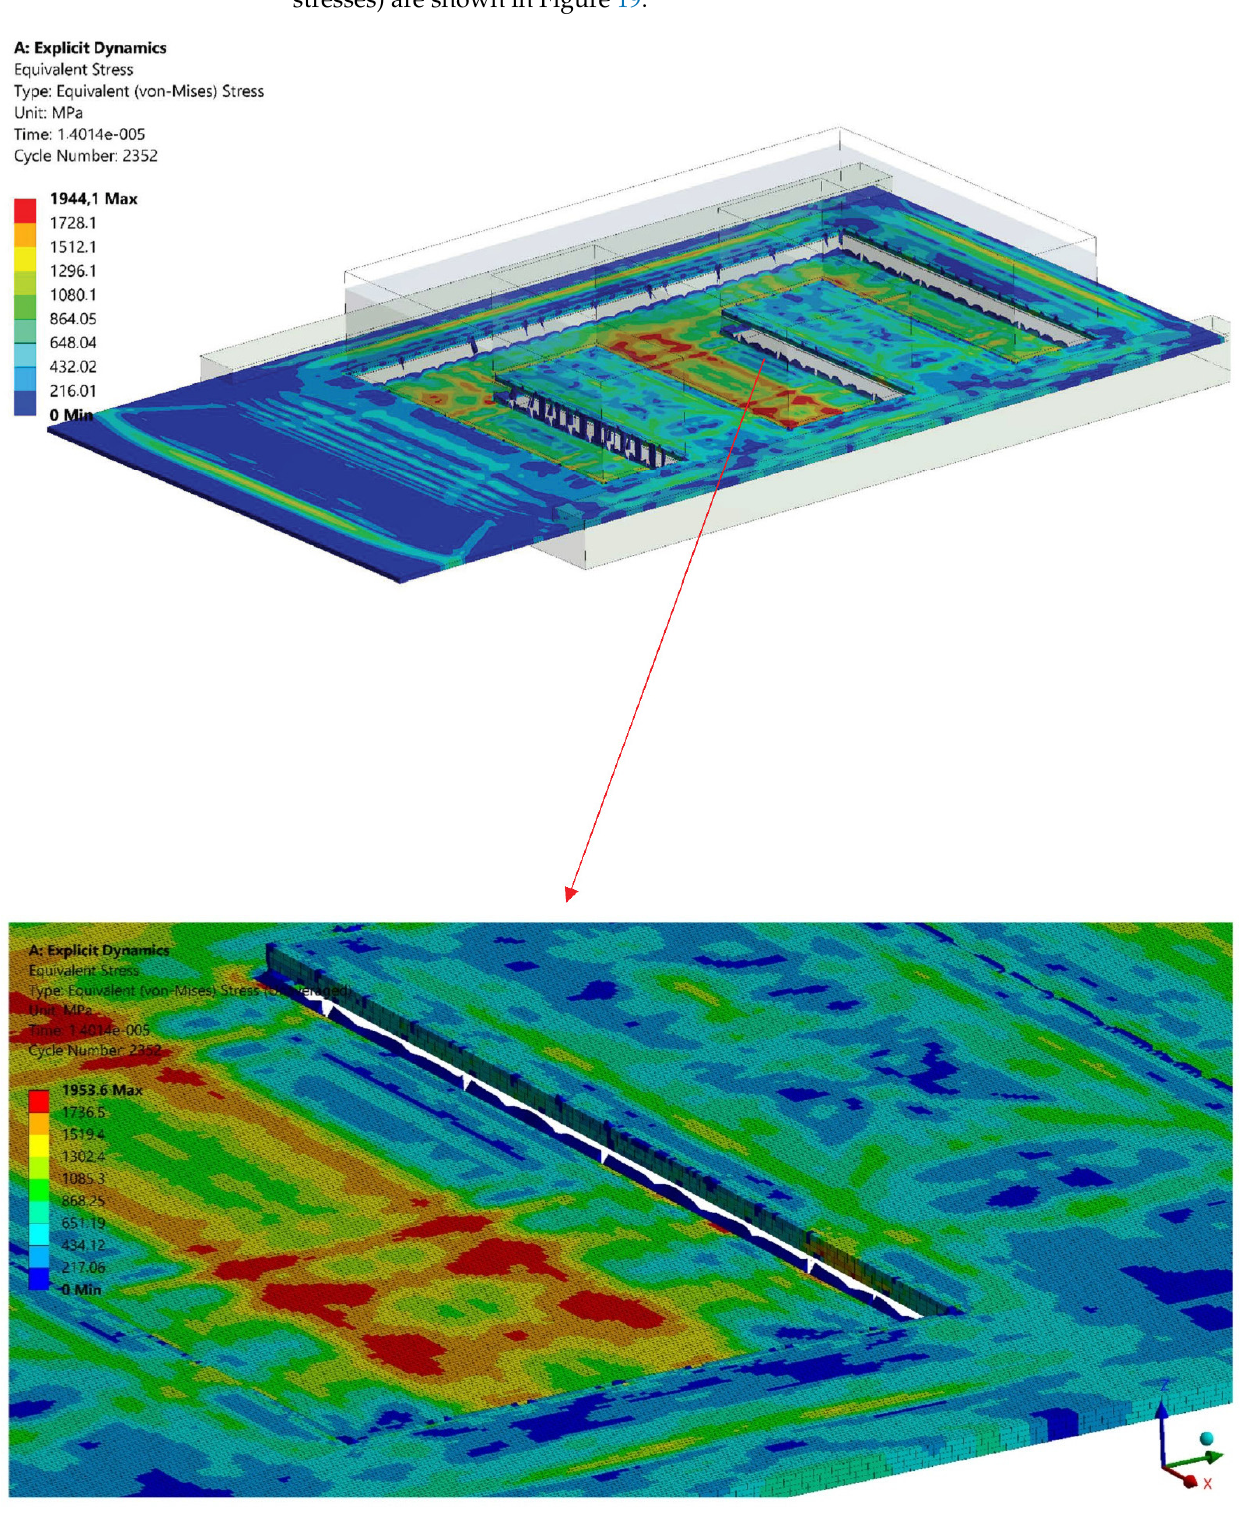
Figure 19. State of equivalent von Mises stress.